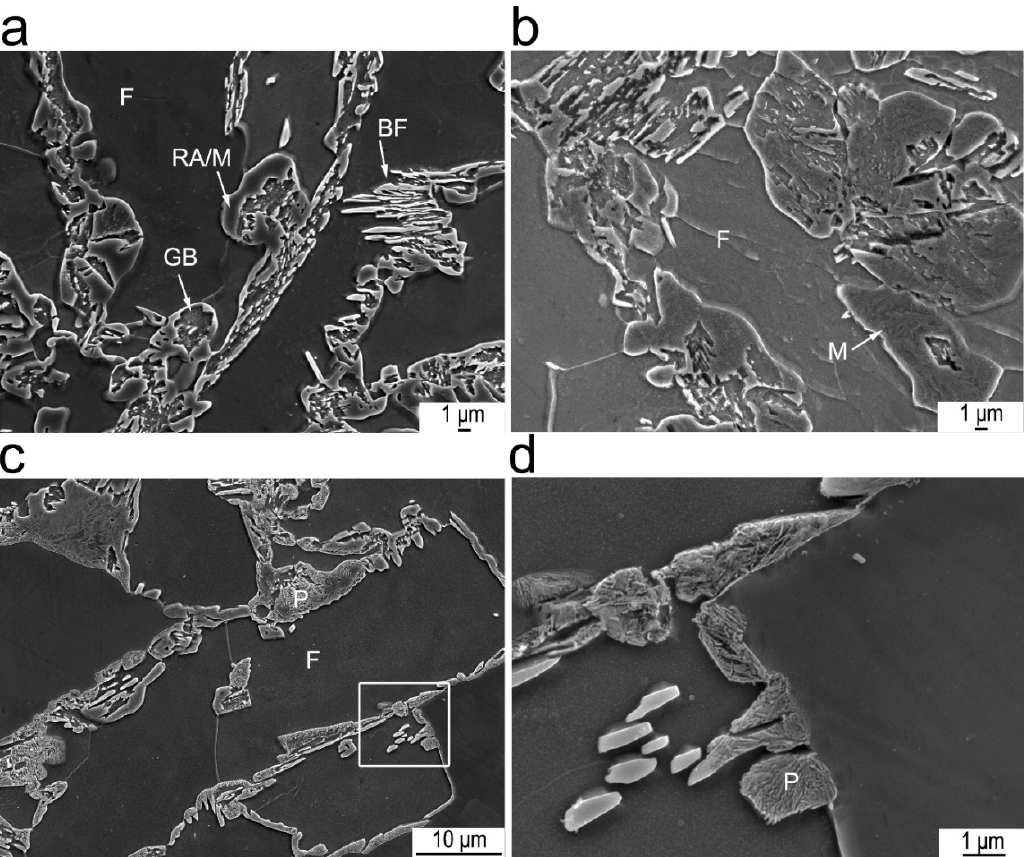
Figure 10. Microstructures after holding at ( a ) 400 °C, ( b ) 450 °C and ( c , d ) 500 °C for 900 s (15 min) following holding at 750 °C for 240 s. F is ferrite, BF is bainitic ferrite, GB is granular bainite, RA/M is retained austenite/martensite constituent, M is martensite and P is pearlite.